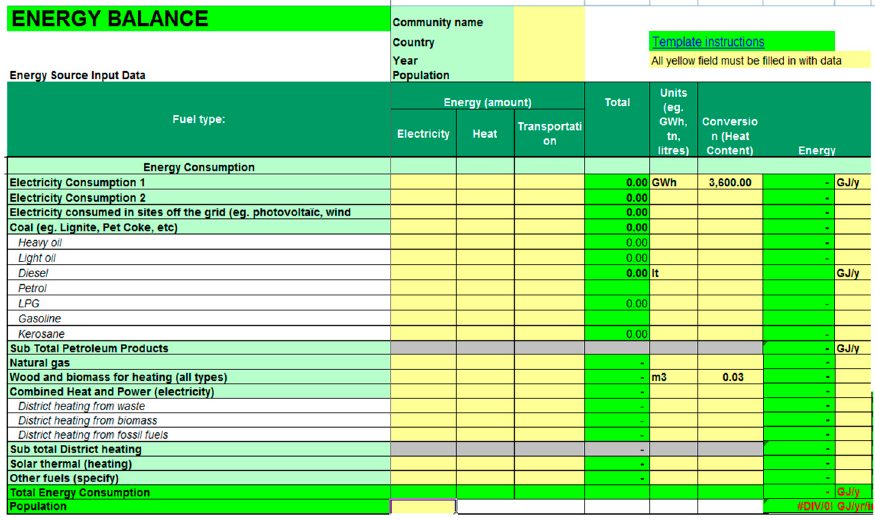
Figure 7. Energy consumption of the community.